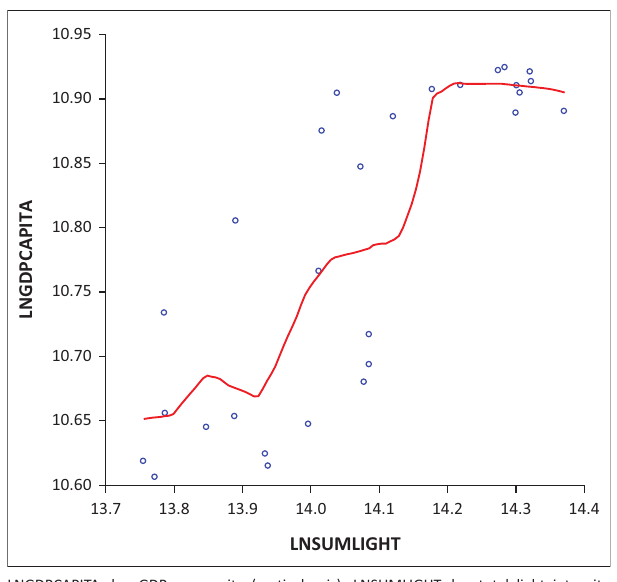
FIGURE 8: Kernel assessment of gross domestic product per capita and total light intensity.